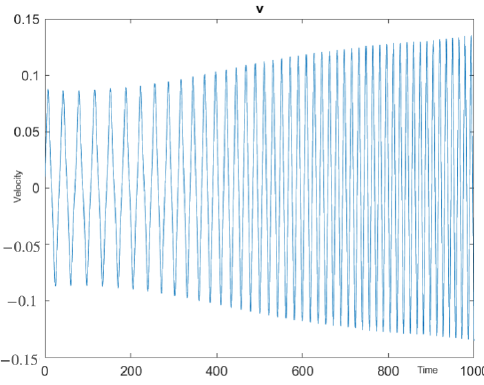
Figure 8. v evolution taking v 0 =